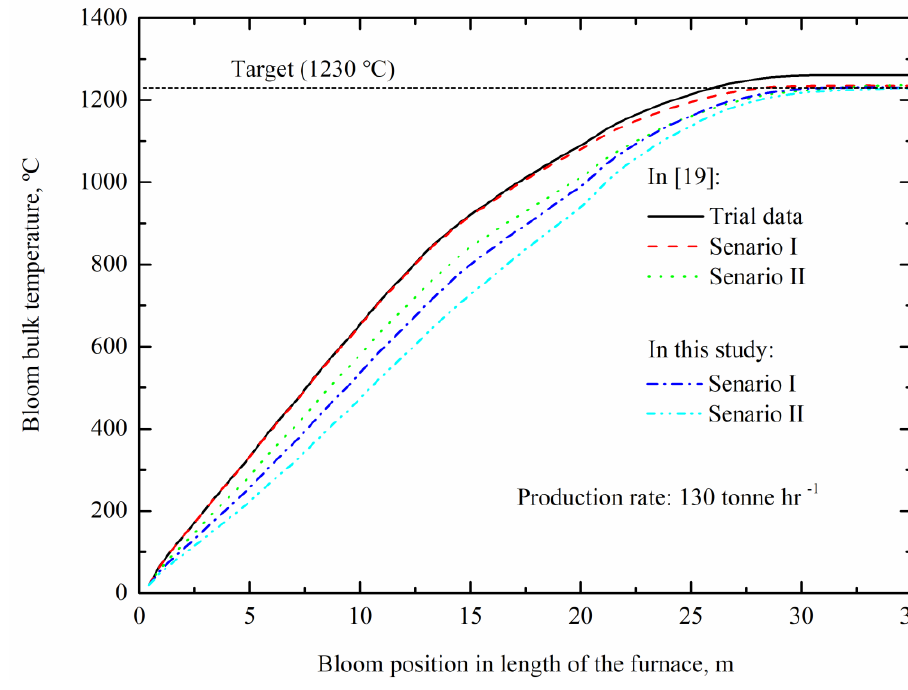
Figure 12. Comparison of heating curves under different optimisation scenarios and methods. Table 6 . Comparison of energy input under different optimisation scenarios and methods.